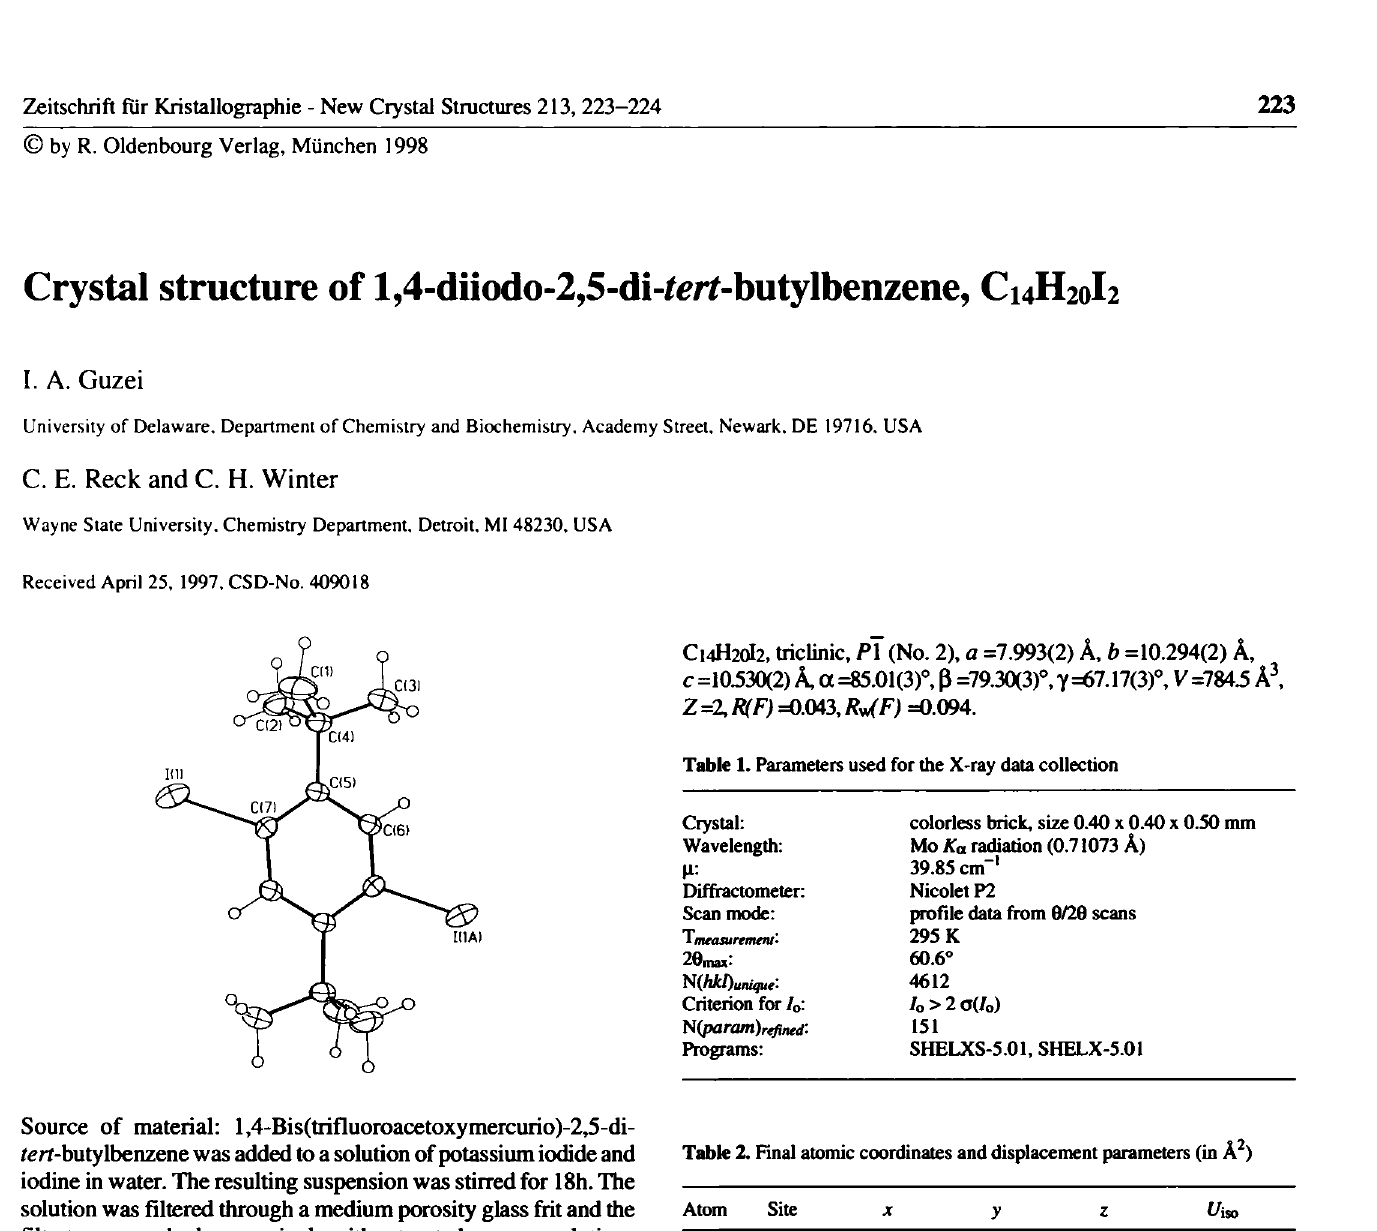
Table 2. Final atomic coordinates and displacement parameters (in